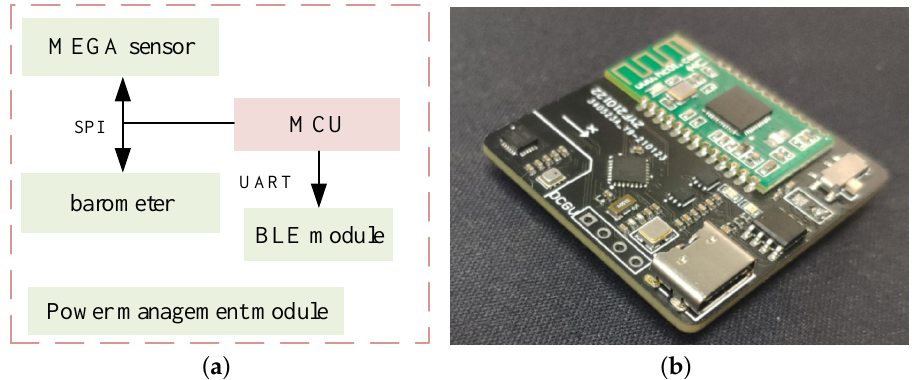
Figure 5. ( a ) System hardware block diagram ( b ) Physical